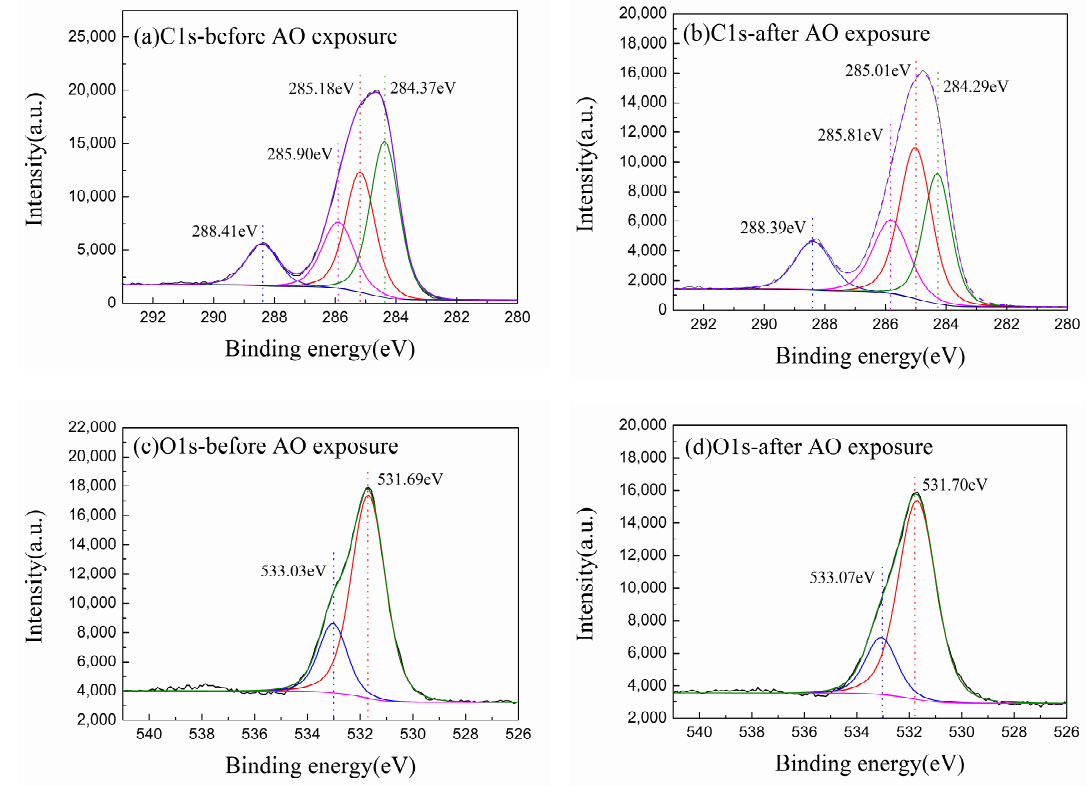
Figure 13. High-resolution spectra of C1 s and O1 s before and after exposure of the Kapton films: ( a , b ): C1 s ; ( c , d ): O1 s .